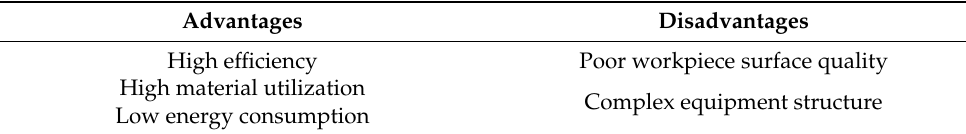
Table 3. Comparison between TFSR process and forging process.